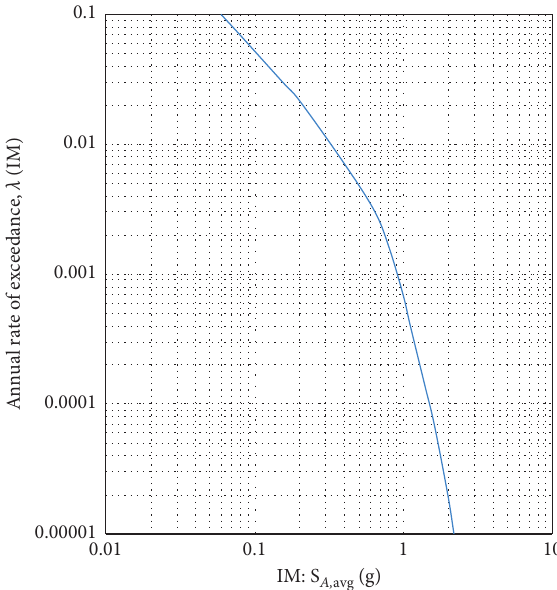
Figure 13: The seismic hazard curve used in this